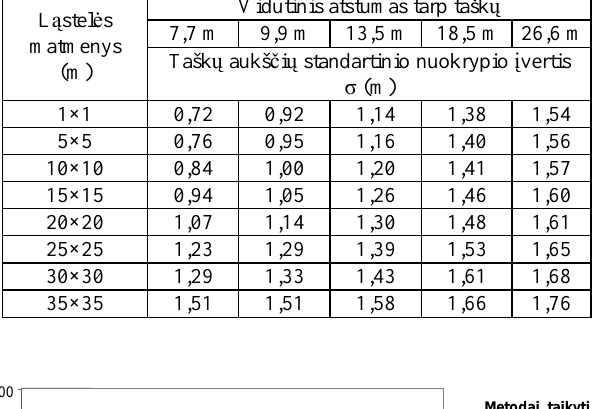
Table 5 . Summary of number of points used for evaluation accuracy in different zones Zonos Tašk ų Zonos Tašk ų Zonos Tašk ų Nr. sk. Nr. sk. Nr.